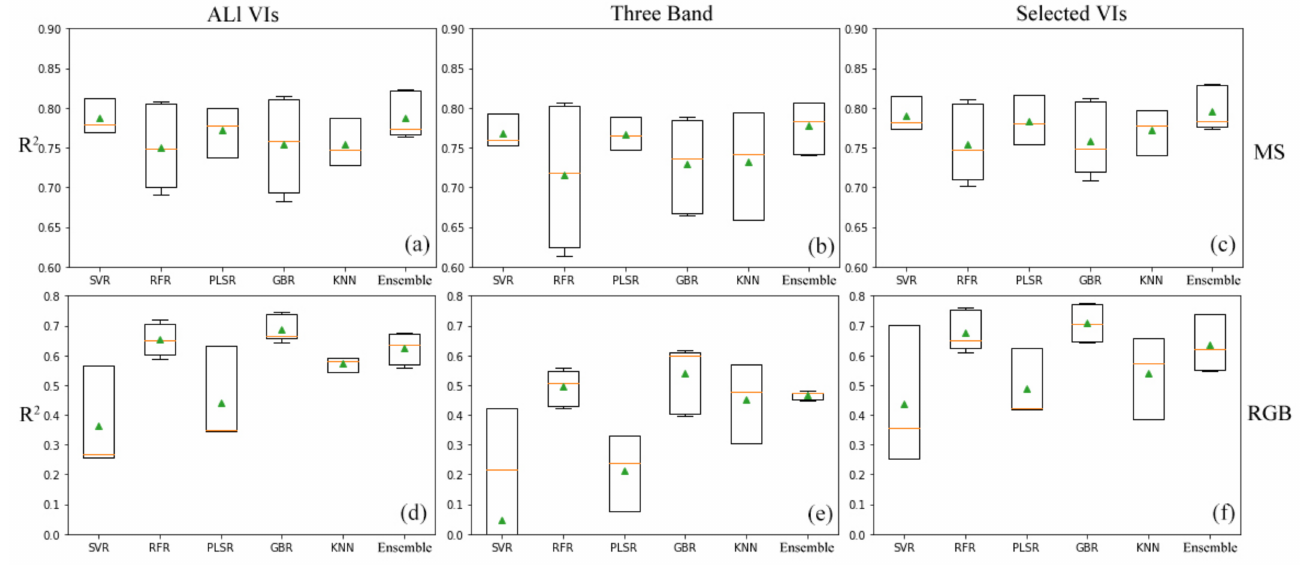
Figure 14. Performance of different models in 0.045 m GSD MS dataset with ( a ) all VIs, ( b ) three band data and ( c ) selected VIs, and RGB datasets with ( d ) all VIs, ( e ) three band data and ( f ) selected